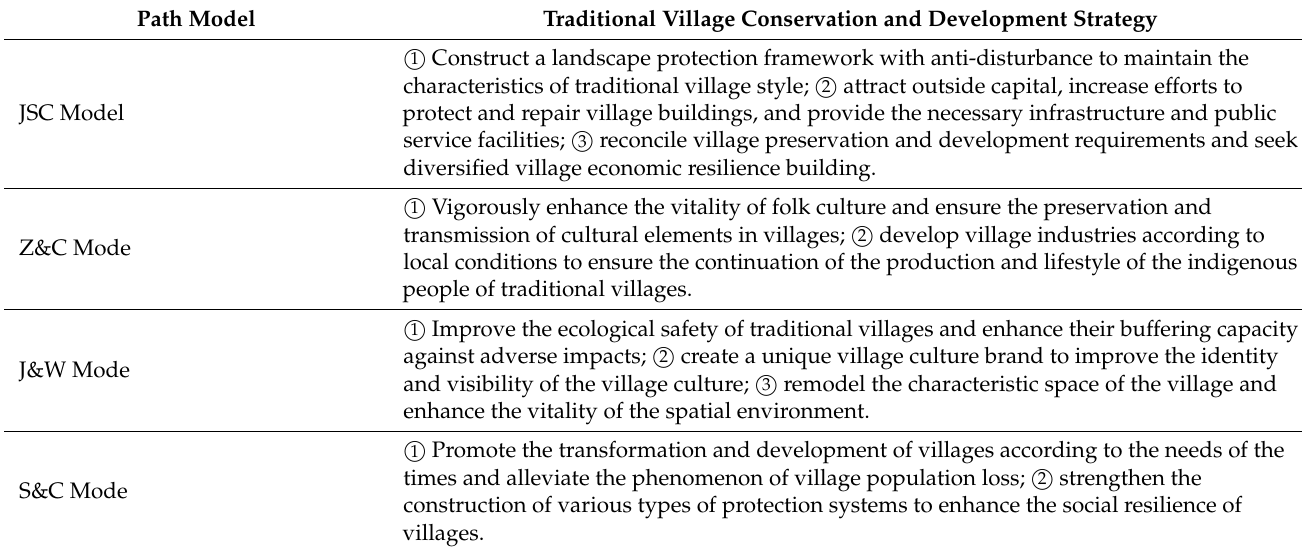
Table 14. Action mechanism of each path mode.